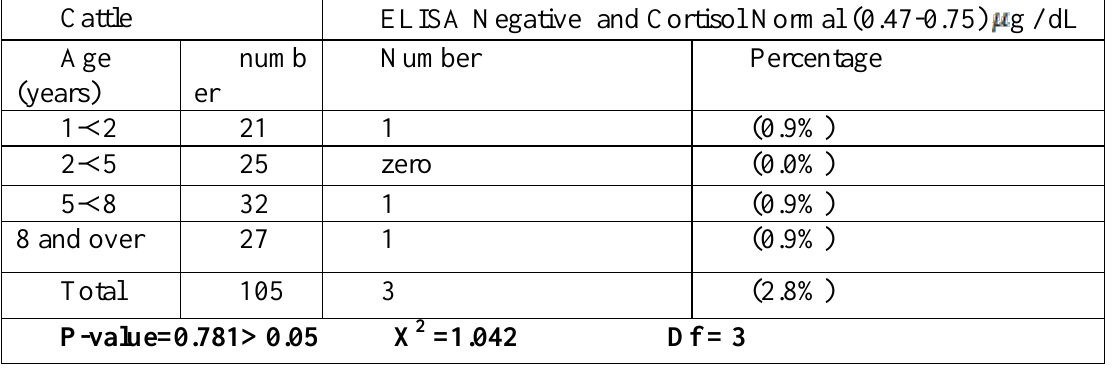
Table(6 ): The fourth group ELISA Negative and Cortisol Normal Cattle ELISA Negative and Cortisol Normal (0.47-0.75) g / dL